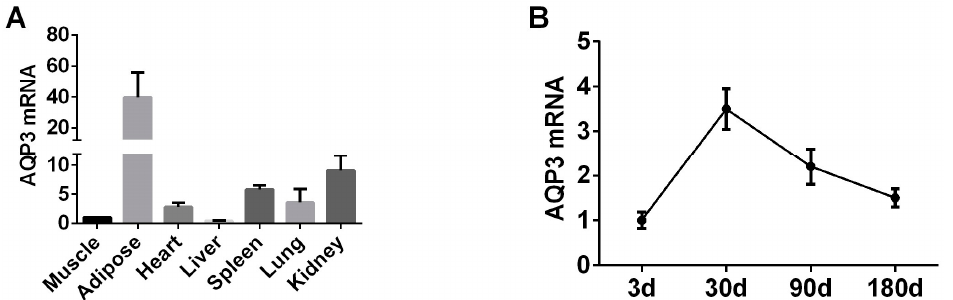
Figure 1. AQP3 expression pattern in pigs in vivo by RT-qPCR. ( A ) AQP3 pig tissue expression profile. ( B ) AQP3 expression during pig growth by RT-qPCR. β -actin was used as internal reference gene. n = 3.